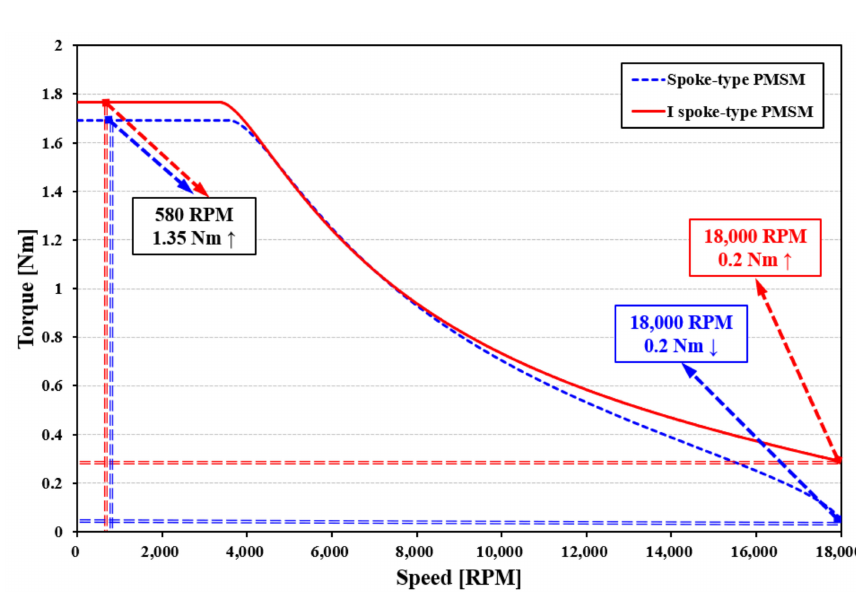
Figure 7. Comparison of T-N